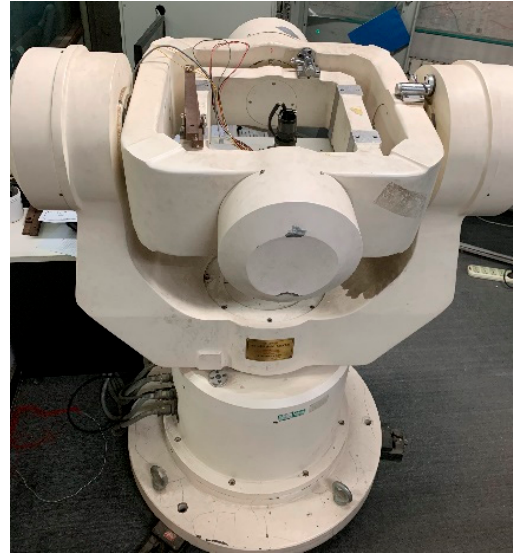
Figure 2. Setup equipment used during the test.